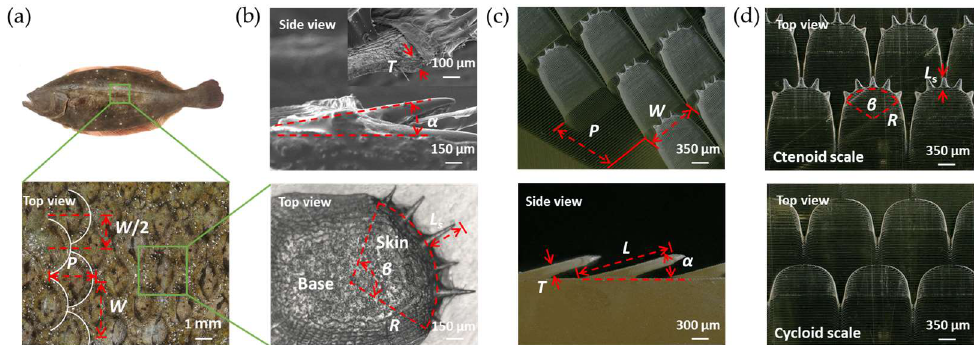
Figure 1. Flounder skin prototype morphology and bionic structure surface. ( a ) Flounder in full view and scales on the flounder skin. ( b ) Structural features of individual scales. ( c ) 3D view and side view of the bionic surface. ( d ) Structural features of ctenoid scale and cycloid scale.